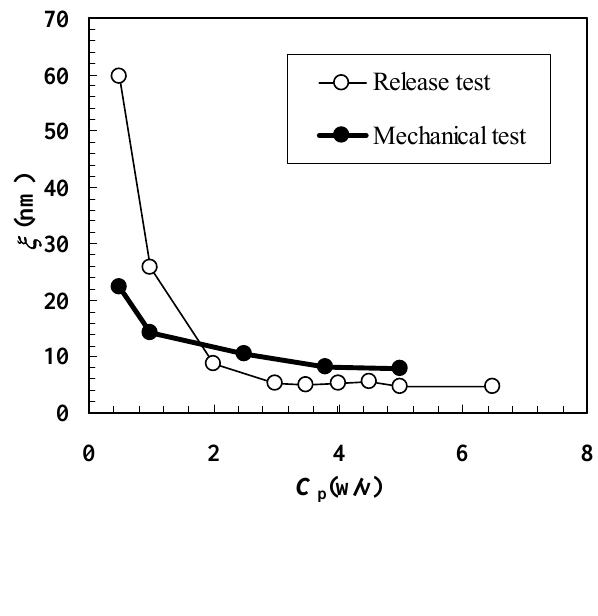
represents the polymer p